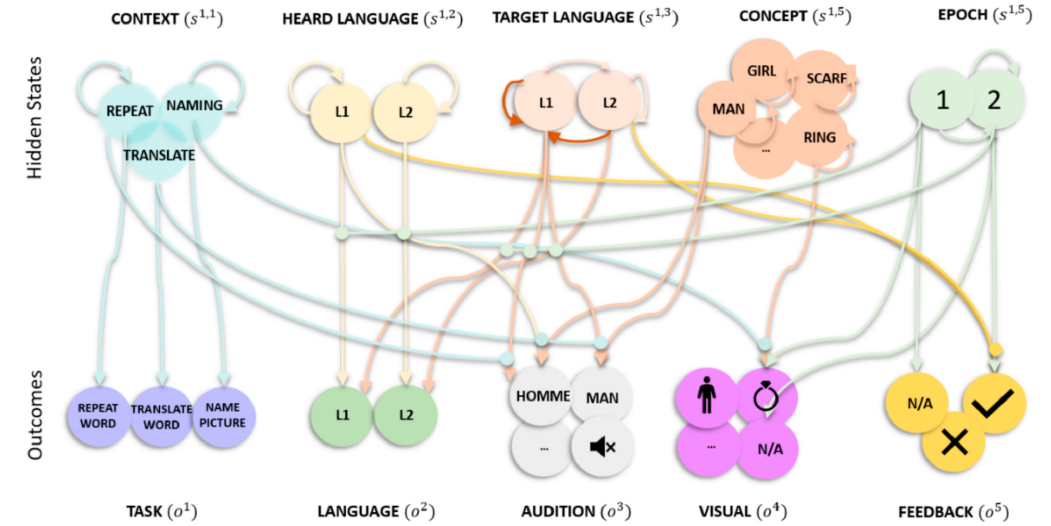
Figure 1. (generative model) Graphical representation of the picture naming, word repetition and translation tasks. There are five outcome modalities: task, language, audition, visual and feedback, and five (hidden) state factors with the following levels (i.e., possible alternative states). Context (3 levels) indexes the current task (naming, repetition, translation). The heard language factor (2 levels) lists the languages the experimenter can use to test the participant (L1 or L2). The target language factor (2 levels) lists the languages the participant can respond in (L1 or L2). The concept factor (12 levels) lists the concepts that the experimenter can ask the participant to name, repeat or translate. The epoch (2 levels) indexes the phase of the trial (stimulus presentation, response and feedback). The lines from states to outcomes represent the likelihood mapping and the lines mapping states within a factor represent allowable state transitions. To avoid visual clutter, we have highlighted likelihoods and transition probabilities that are conserved over state factors and outcome modalities. For example, in the audition likelihood mapping for translation, the target language and concept (man) to audition (homme) is shown for epoch 1, but similar mappings apply when mapping between girl and fille, etc. One (out of two) example transition probability is highlighted (in darker brown shade) for the target language, i.e., the transition is always to L1, regardless of previous target language. This transition represents the choice to speak in L1. Similar mappings are applied when choosing to speak in L2, regardless of the previous